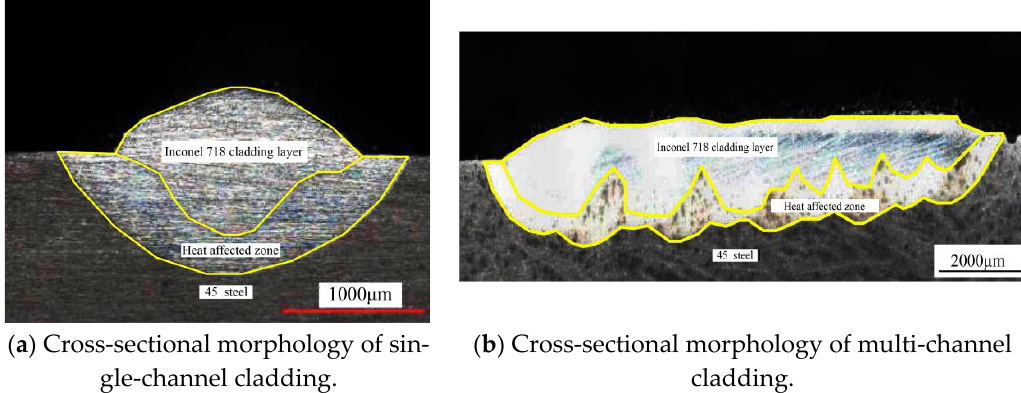
( b ) Cross-sectional morphology of multi-channel cladding. Figure 14. Surface morphology and cross-sectional morphology of cladding